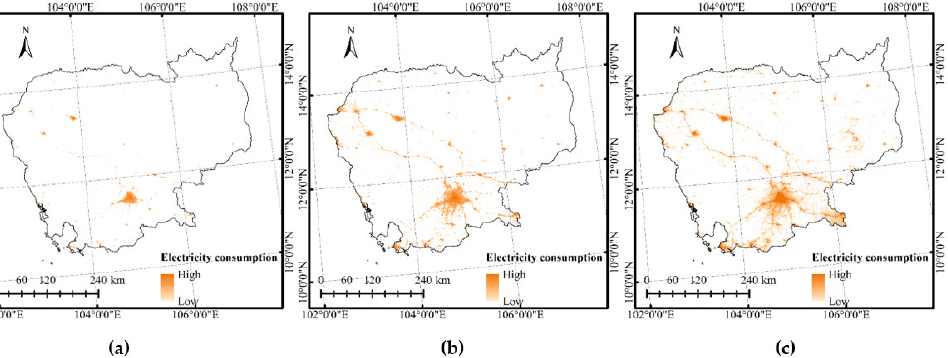
Figure 6. Spatial distributions of electricity consumption in Cambodia in years ( a ) 2012, ( b ) 2015, and ( c ) 2018.